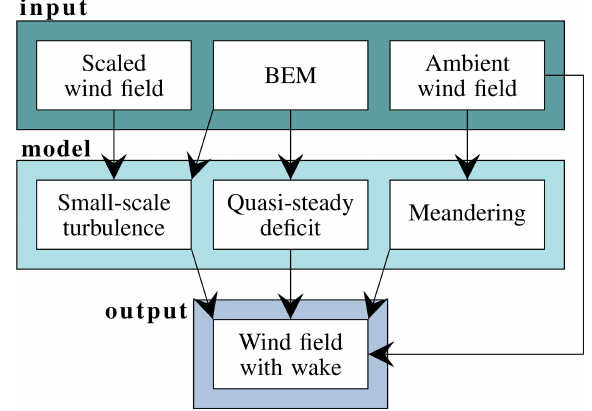
Figure 3. Components of the DWM model (adapted from Rein- wardt et al.,